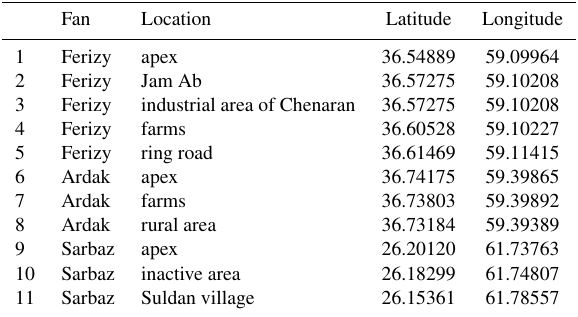
Table 1. Observation conclusions from field